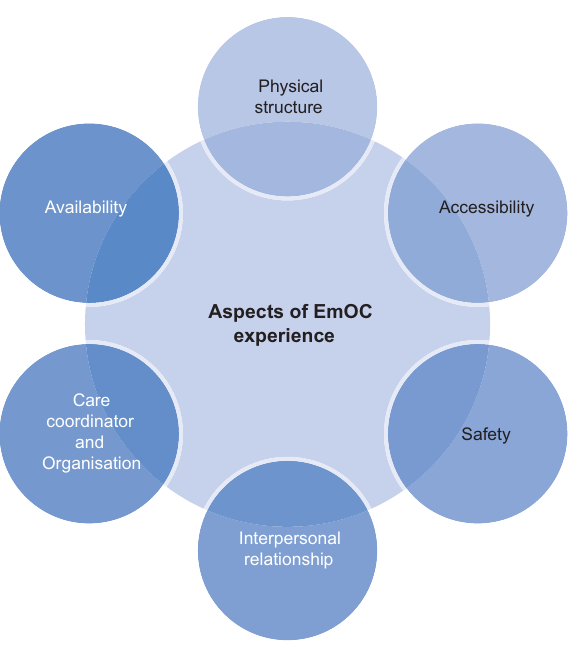
Figure 2: Clients’ aspects of EmOC